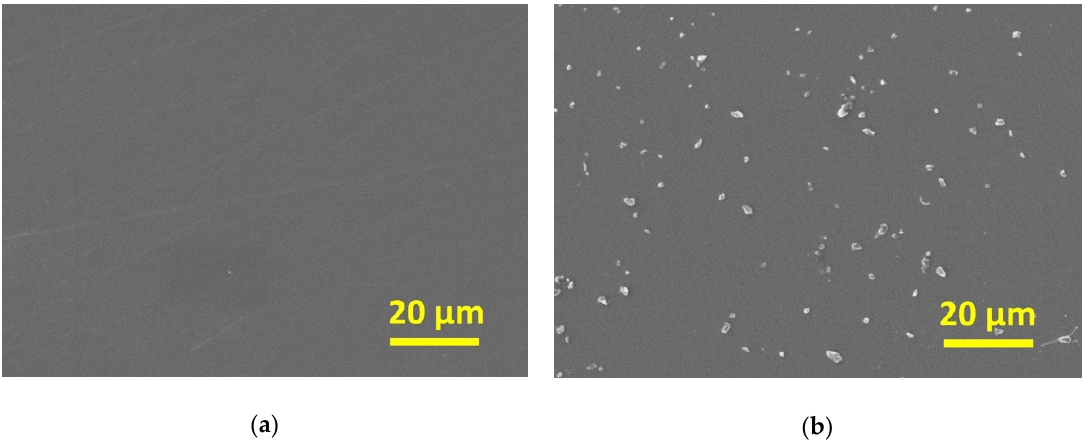
Figure 1. SEM images of low magnification (× 1000): ( a ) control; ( b ) nano-Ag coating. The small particles covered the nano-Ag coating.